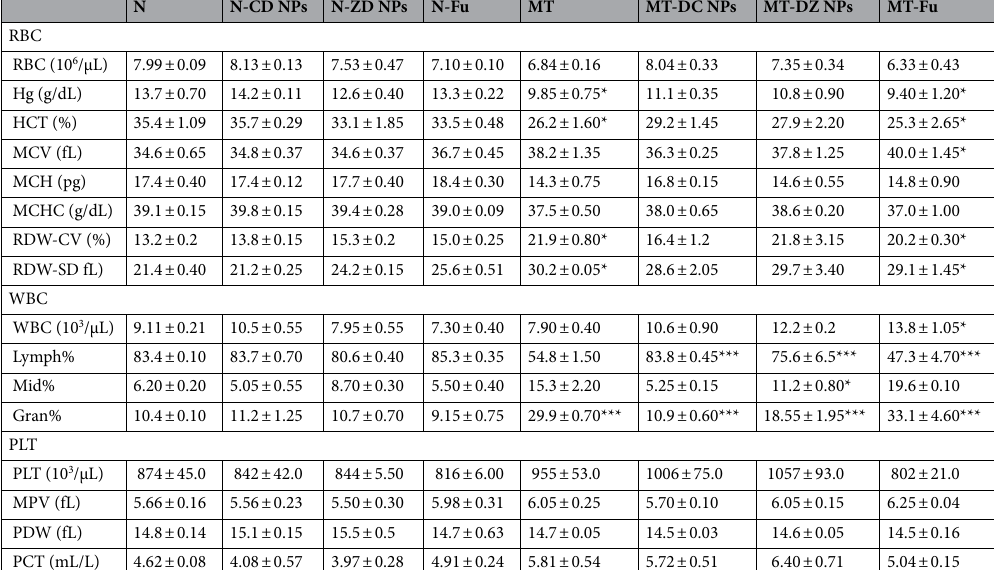
Table 2. Hematological parameters. N the untreated healthy control normal mouse group, N‑CD NPs nanocomplex of Cu 4 O 3 with diethyldithiocarbamate (DE)-treated normal mouse group, N‑ZD NPs nanocomplex of ZnO with DE-treated normal mouse group, N‑Fu 5-fluorouracil-treated normal mouse group, MT the untreated mammary tumor-bearing mouse group, MT‑CD NPs CD NPs-treated MT group, MT‑ZD NPs ZD NPs-treated MT, and MT‑Fu Fu-treated MT group, RBC red blood cell, Hg hemoglobin, HCT hematocrit, MCV mean corpuscular volume, fL 10 –15 L, MCH mean corpuscular hemoglobin, MCHC mean corpuscular hemoglobin concentration, RDW‑CV and RDW‑SD red blood cell distribution width-coefficient of variation and standard deviation, WBC white blood cell, Lymph lymphocyte, Mid monocytes, eosinophils and basophils, Gran granulocyte, PLT platelet, MPV mean platelet volume, PDW platelet distribution width, and PCT plateletcrit. All values are demonstrated as mean ± SEM. N group was compared to other groups and considered significantly different at p < 0.05*, < 0.01**, and <